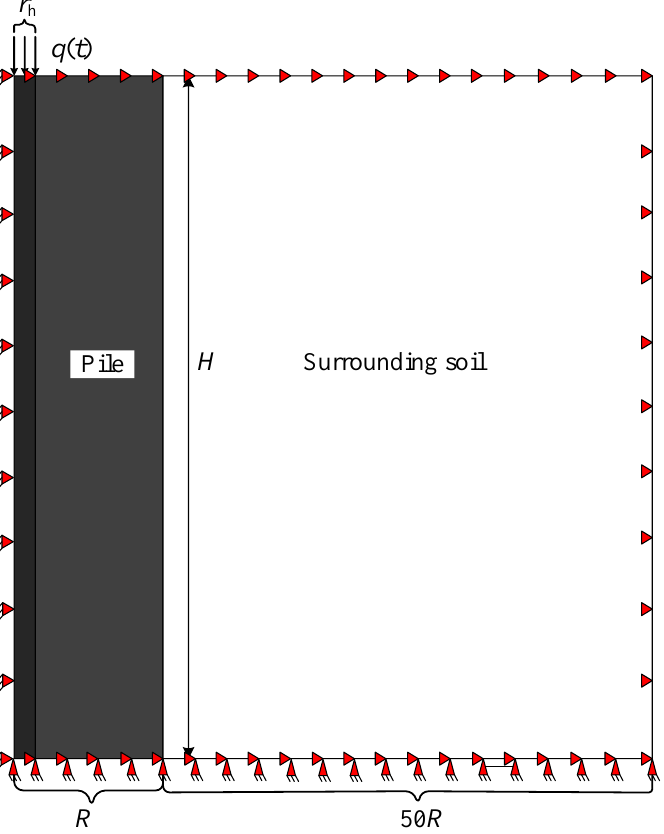
Figure 2. Finite element model of the pile-soil system. Table 1. The parameters of the pile-soil system in this paper.